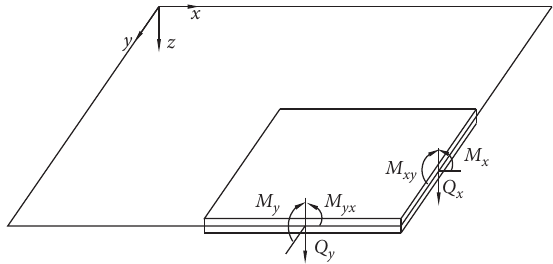
Figure 1: Coordinate system and internal forces.